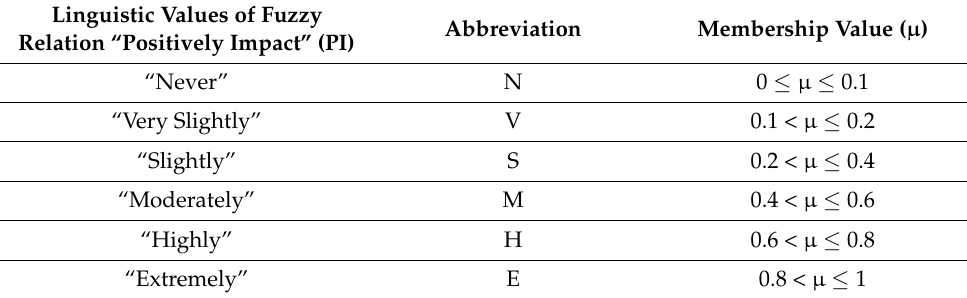
Table 2. Fuzzy relations linguistic and numerical membership values